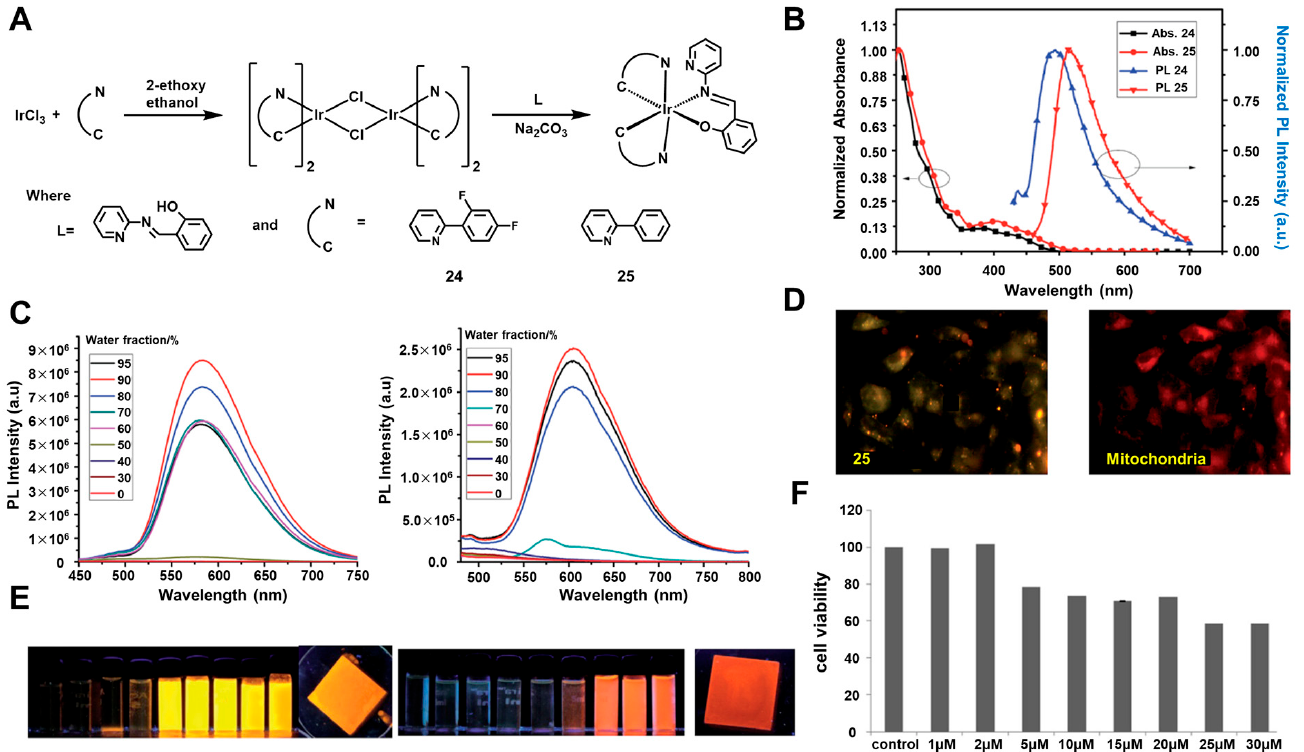
Figure 9. ( A ) Synthetic routes for complexes 24 and 25 . ( B ) Absorption and photoluminescence spectra of 24 and 25 . (The arrows indicate the corresponding ordinate, The circles represent the absorption or emission curve of the materials). ( C ) PL spectra of 24 and 25 in MeOH/water mixed solvents with different water fractions. ( D ) Intracellular compound localization of 25 in HOS cells. ( E ) Luminescent images of 24 and 25 in solutions with different water fractions and solid sample of 24 and 25 under irradiation with a 365 nm UV lamp. ( F ) Cytotoxicity assay for 25 in HOS cells. Reprinted with permission from [70] , copyright 2017, Royal Society of Chemistry.